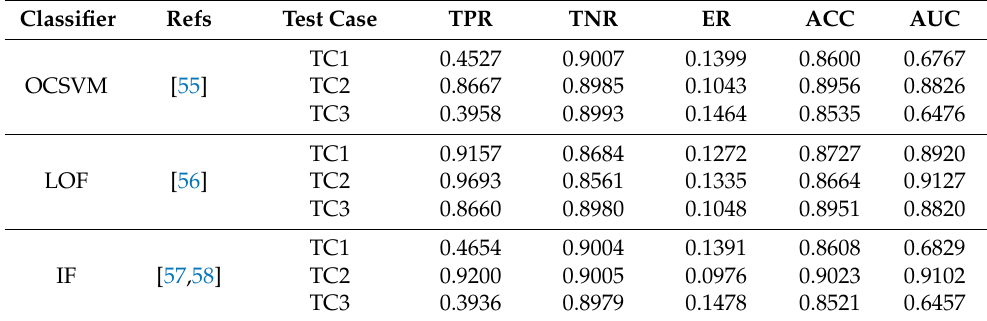
Table 3. Summary of